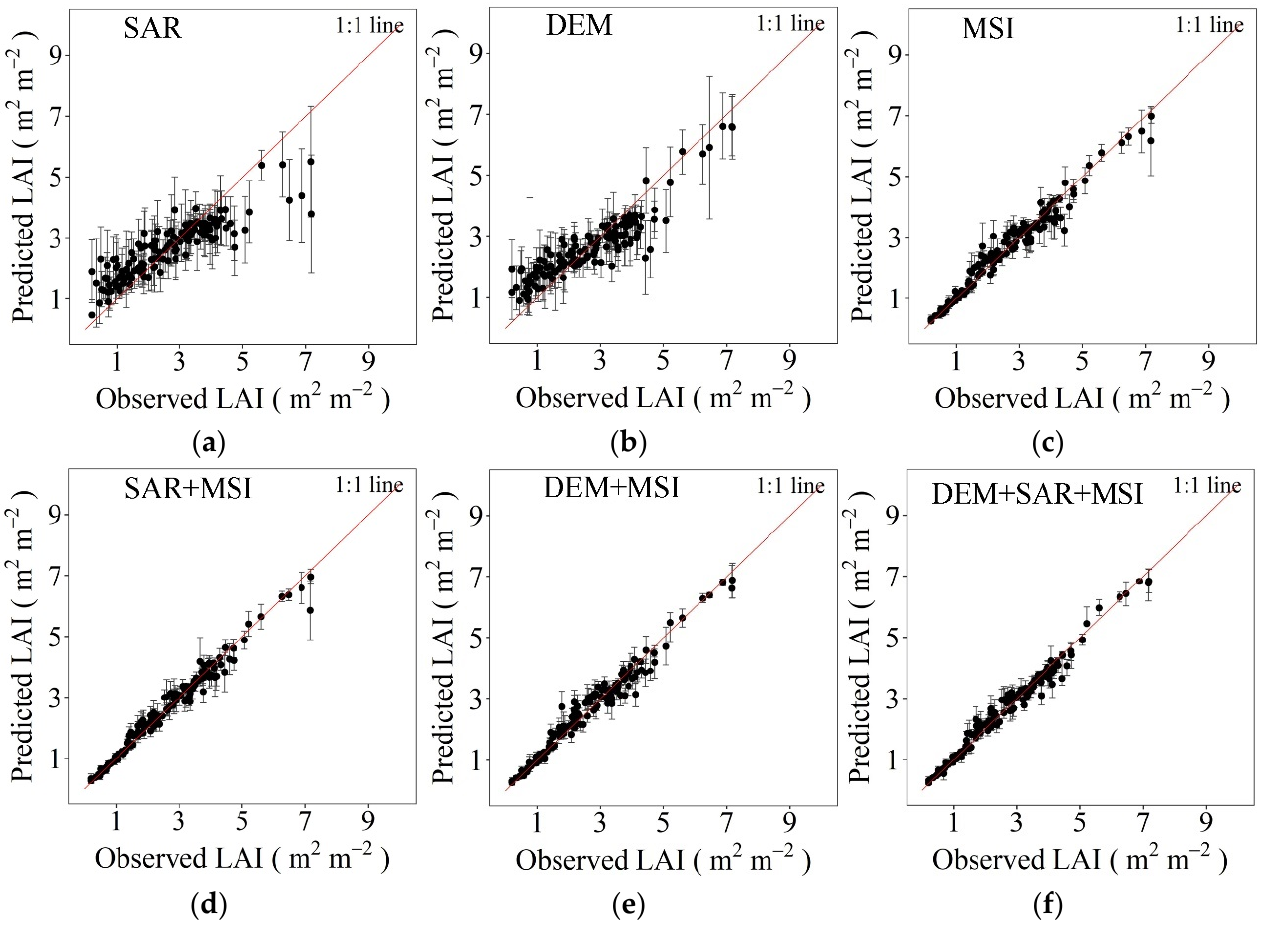
Figure 5. Observed LAI versus predicted LAI using SL model calculated from the ( a ) SAR, ( b ) DEM, ( c ) MSI, ( d ) SAR + MSI, ( e ) DEM + MSI and ( f ) DEM + SAR + MSI data in Xingguo.